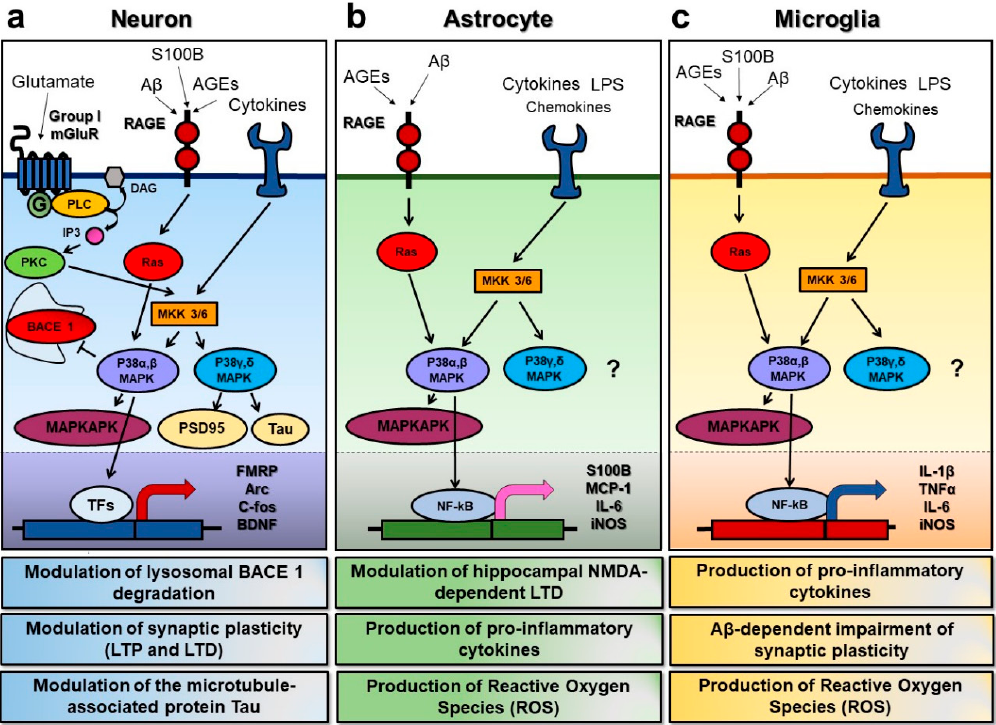
Figure 1. Overview of the p38 mitogen activated protein kinase (MAPK) signal transduction pathways in neurons, astrocytes, and microglia. p38 MAPK can be activated in response to various extracellular stimuli, such as glutamate, advanced glycation endproducts (AGEs), cytokines, and chemokines, leading to cell type-specific downstream effects. ( a ) In neuronal cells, the activation of the metabotropic glutamate receptors of group I (group I mGluRs) can turn on phospholipase C (PLC) and promote the phosphorylation of MAP kinase kinase 3/6 (MKK 3/6), with the subsequent activation of the p38 MAPKs. The α and β isoforms of p38 MAPK have been shown to inhibit beta-secretase 1 degradation, to promote the activation of MAP kinase activated protein kinase (MAPKAKP), and to act on specific transcription factors (TFs) to induce changes in the expression of the key proteins involved in synaptic plasticity, such as the fragile X mental retardation protein (FMRP), the activity-regulated cytoskeleton-associated protein (Arc), the c-fos protein, and the brain-derived neurotrophic factor (BDNF). On the other hand, the γ and δ isoforms seem to have a role in the modulation of synaptic proteins, such as postsynaptic density protein 95 (PSD95) and the microtubule-associated protein Tau. Furthermore, AGEs binding to the receptor for advanced glycation endproducts (RAGE) can turn on the Ras protein, and predominantly lead to the activation of p38 α and β isoforms, while cytokines and chemokines can trigger p38 MAPK by acting through their specific receptors and via MKKs. ( b ) In astrocytes, AGEs and pro-inflammatory molecules such as lipopolysaccharide (LPS) can lead to p38 MAPK activation as well. Moreover, p38 activation in this specific cell type has been demonstrated to modulate hippocampal n-methyl-d-aspartate (NMDA)-dependent long-term depression (LTD), to induce the production of the S100 calcium binding protein (S100B), of pro-inflammatory molecules such as the monocyte chemoattractant proten-1 (MCP-1) and interleukin-6, and to increase the production of reactive oxygen species (ROS) via the expression of inducible nitric oxide synthase (iNOS). ( c ) In microglia, the signaling pathways upstream of p38 MAPK activation are very similar to those found in astrocytes. However, in addition, they lead to the production of pro-inflammatory cytokines such as interleukin-1 β , the tumor necrosis factor α , and IL-6, and to increase ROS production, microglial activation of the p38 α isoform has been demonstrated to play a key role in the A β -dependent synaptic dysfunction.